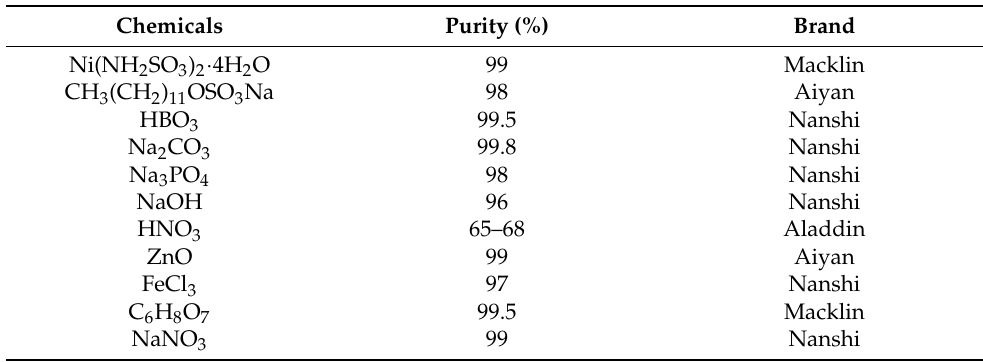
Table 3. The chemicals.